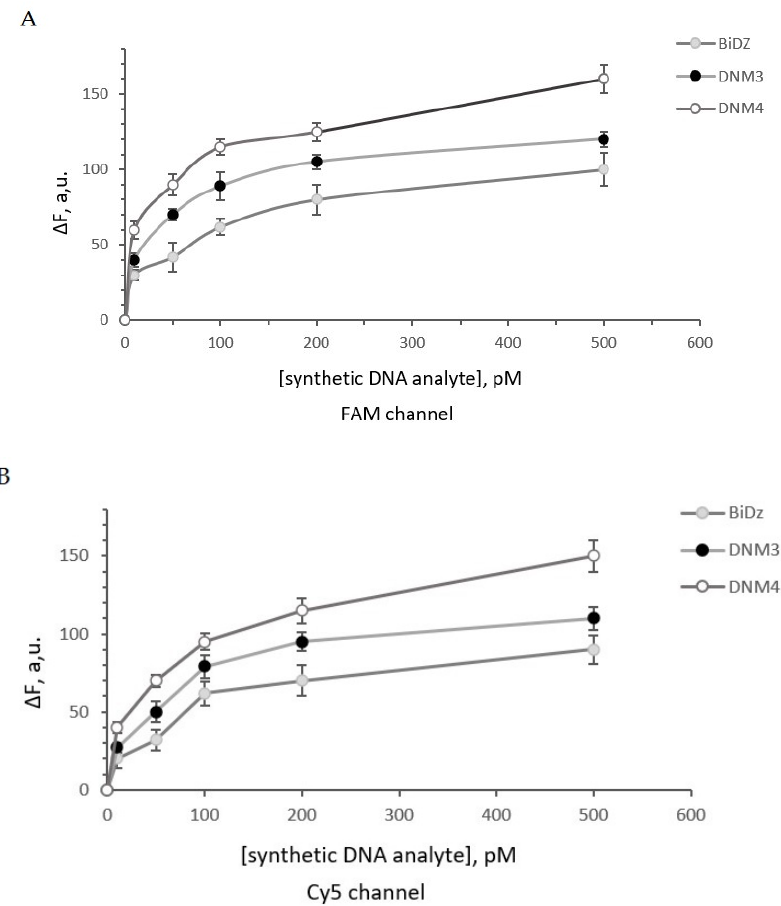
Figure 3. Fluorescence response of the sensors in the presence of different concentrations (0–500 pM) of the synthetic analytes (Analyte-thu and Analyte-myc, Table S1) after 1 h of incubation at 55 °C. ( A ) Response of B. thuringiensis –specific DNA nanosensors in the FAM channel. ( B ) Response of B. mycoides –specific DNA nanosensors in the Cy5 channel. Average values of three independent measurements are presented with one standard deviation. Tables S2 and S3 contain data correspond to Figure 3A and Figure 3B, respectively. Table 2. Limit of detection for all the DNA nanosensors for the synthetic analyte. LOD, pM Sensor Analyte